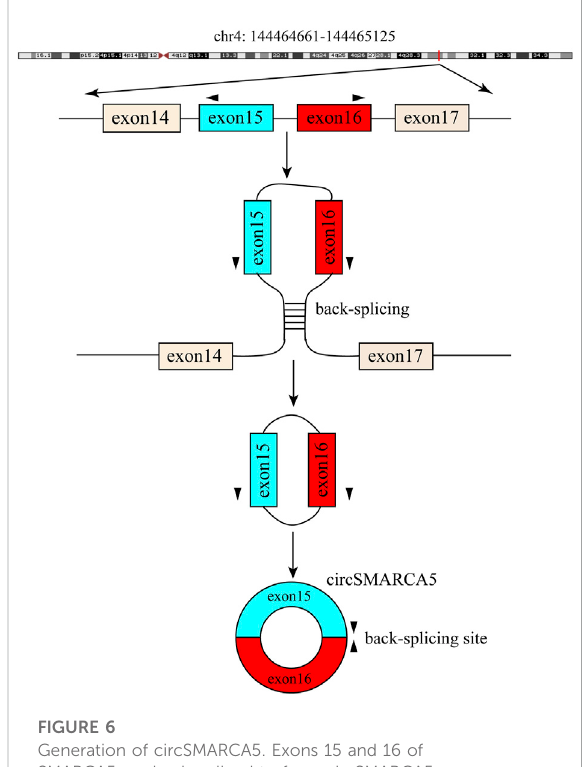
FIGURE 6 Generation of circSMARCA5. Exons 15 and 16 of SMARCA5 are back-spliced to form